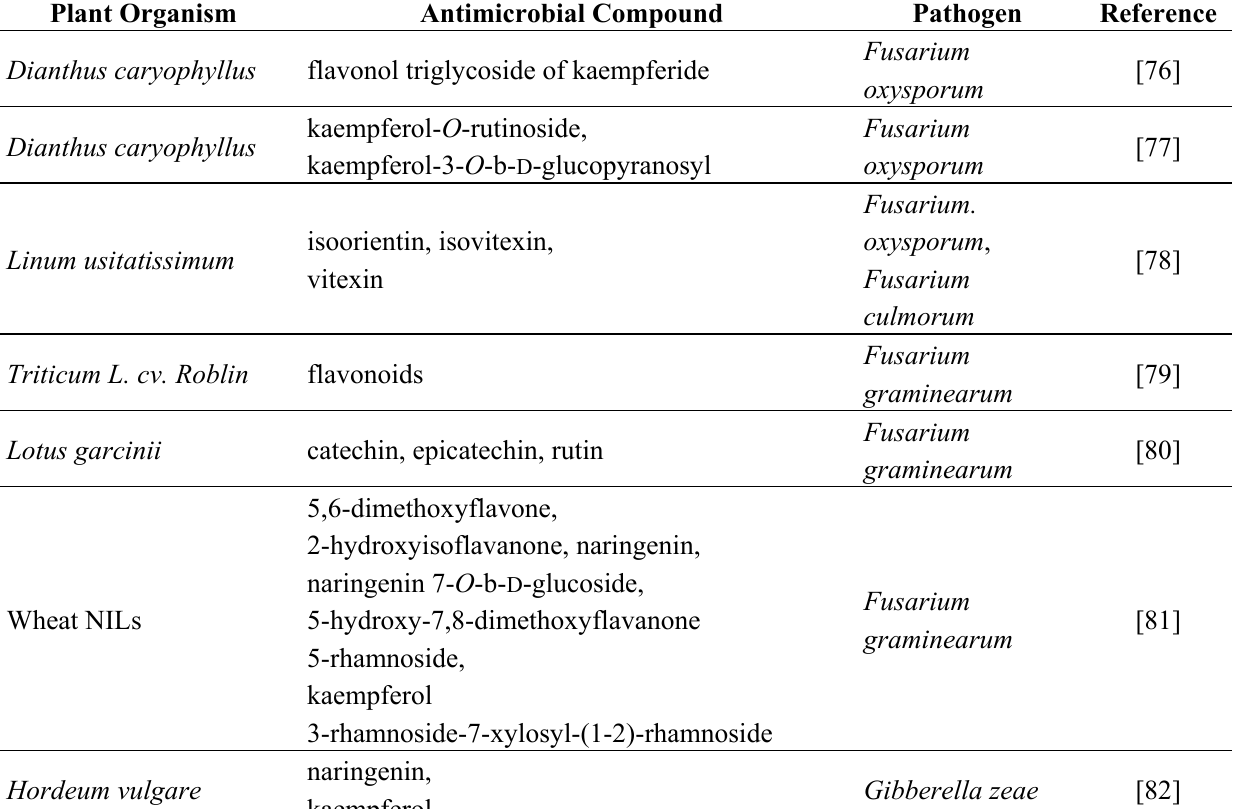
Table 1. List of flavonoid compounds of anti-pathogenic activities found in plant